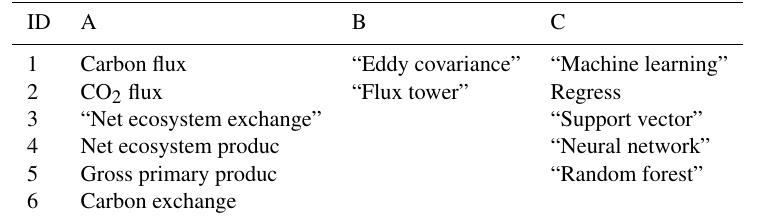
Table 1. Article search query design: “[A1 OR A2 OR A3, etc.] AND [B1 OR B2, etc.] AND [C1 OR C2, etc.]”. ID A B C 1 Carbon flux “Eddy covariance” “Machine learning” 2 CO 2 flux “Flux tower” Regress 3 “Net ecosystem exchange” “Support vector” 4 Net ecosystem produc “Neural network” 5 Gross primary produc “Random forest” 6 Carbon